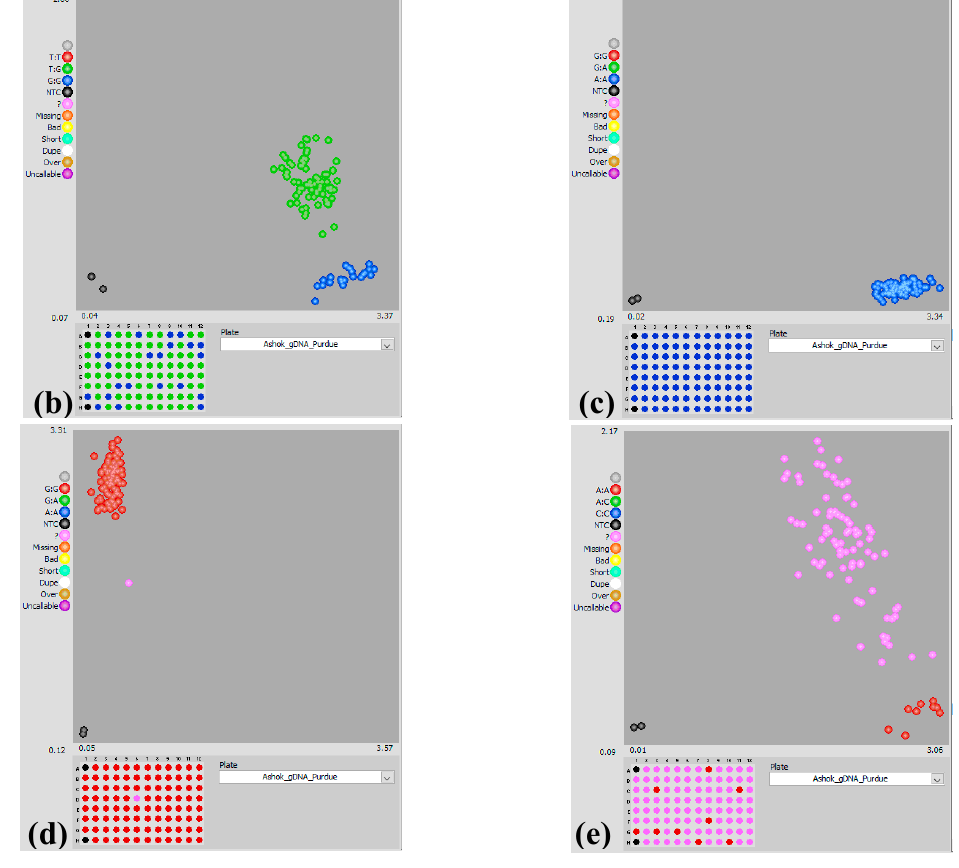
Figure 5. Snapshots showing single nucleotide polymorphism (SNP) genotyping in parental inbred line LM11, CML25, and their F 2 mapping populations with KASP marker assays. The snapshots show ( a ) polymorphic pattern, occurrence of allele specific to LM11 (blue spots) and CML25 (red spots), and heterozygosity for the corresponding alleles (green spots) in F 2 mapping population. ( b ) occurrence of only one allele (blue spots), and heterozygosity for corresponding allele (green spots). ( c ) monomorphic pattern, occurrence of allele specific to LM11 (blue spots). ( d ) monomorphic pattern, occurrence of allele specific to CML25 (red spots), and missing data (pink spot). ( e ) the majority of missing data (pink spots), and one allele (red spots), occurrence of failed amplification signals i.e., invalid markers, in all snapshots black spots represent no template controls (NTCs).